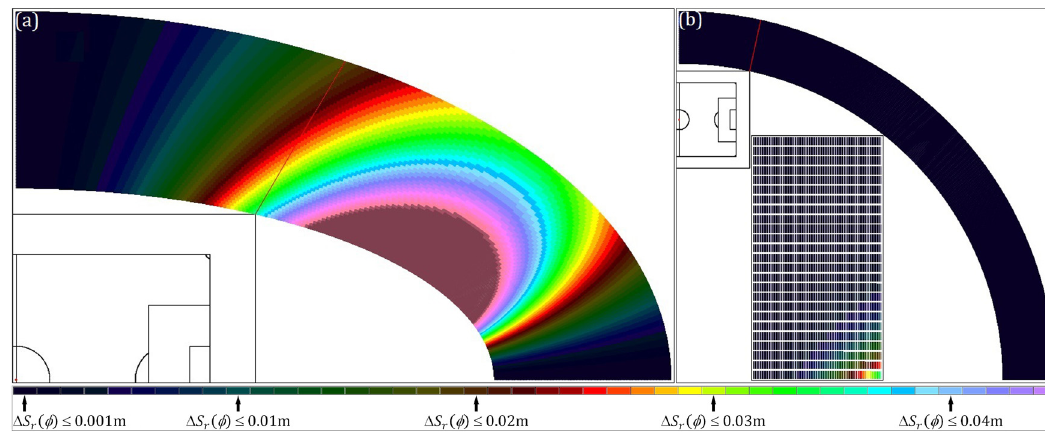
Figure 15: The stands BA, BB: ( a ) top view, ( b ) top view ( corrected ) , and ( c ) color